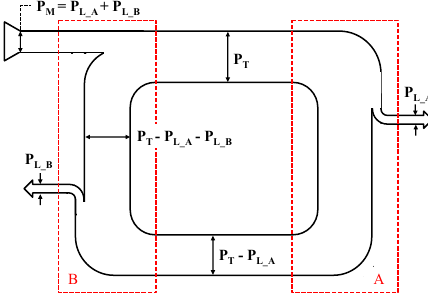
Figure 4. Scheme of power flow in power circulation test rig.